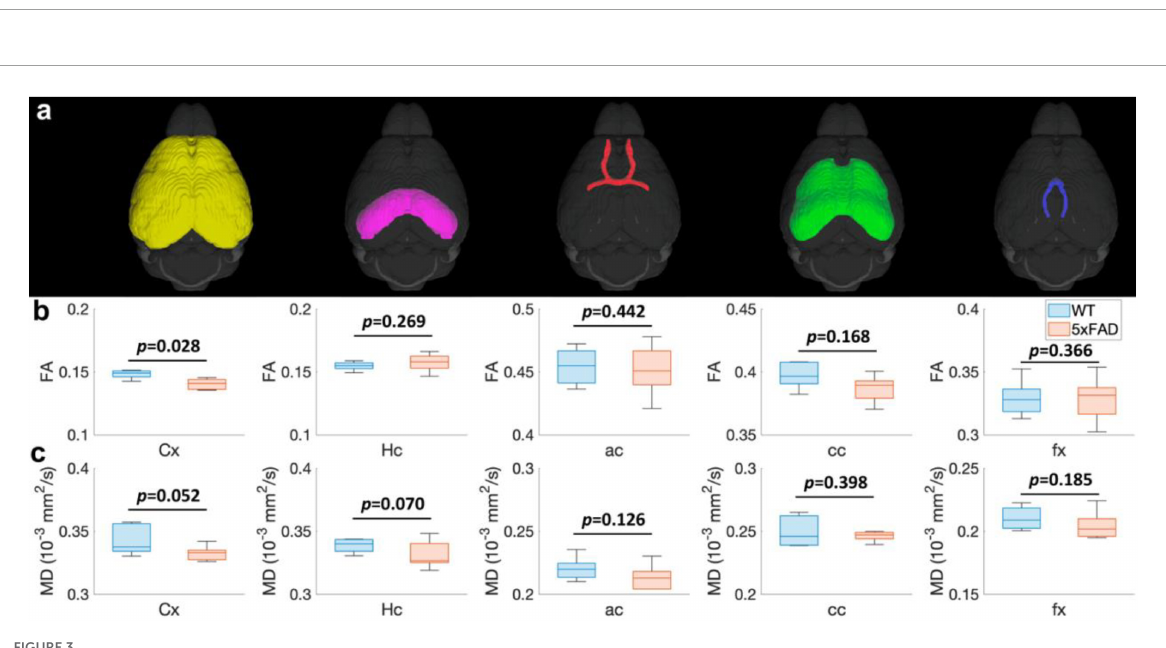
FIGURE3 The FA (B) and MD (C) values at different regions (Cx, Hc, ac, cc, and fx, A ) for both WT and 5xFAD mice at 4 months. Cx: cortex; Hc: hippocampus; ac: anterior commissure; cc: corpus callosum; fx: